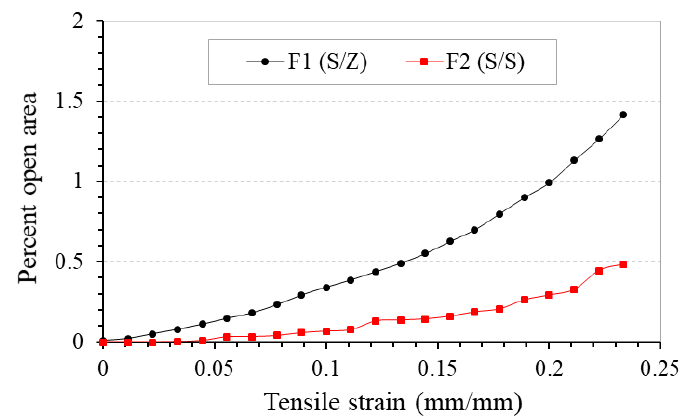
Figure 11. Percent open area-tensile strain curves of fabrics F1 and F2 made of different auxetic yarn arrangements.